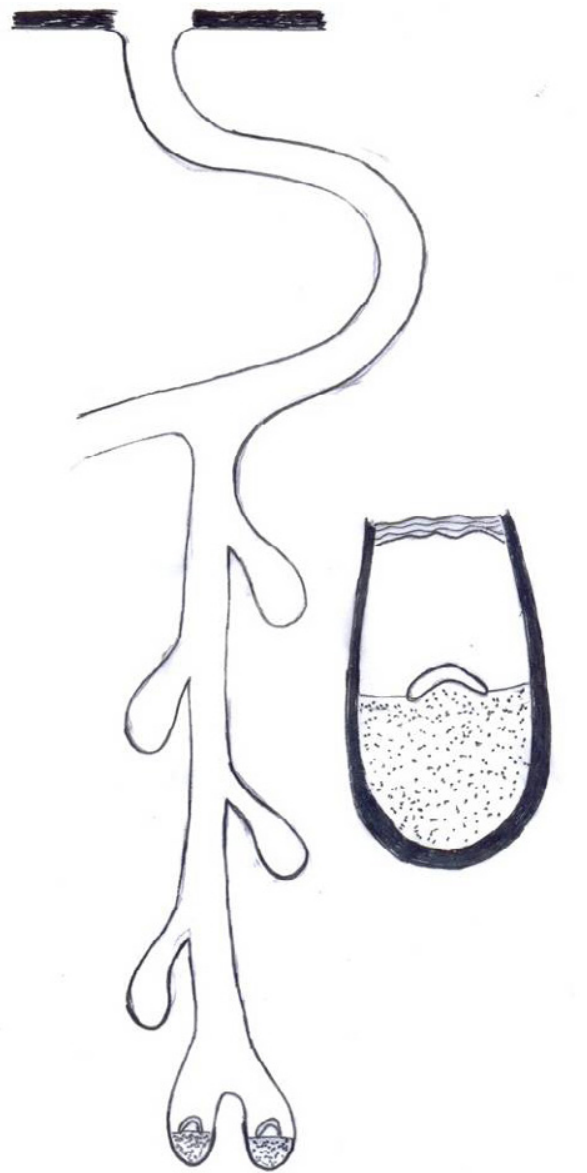
Fig 1 . Nest Architecture of Eucera nigrilabris Lepeletier,